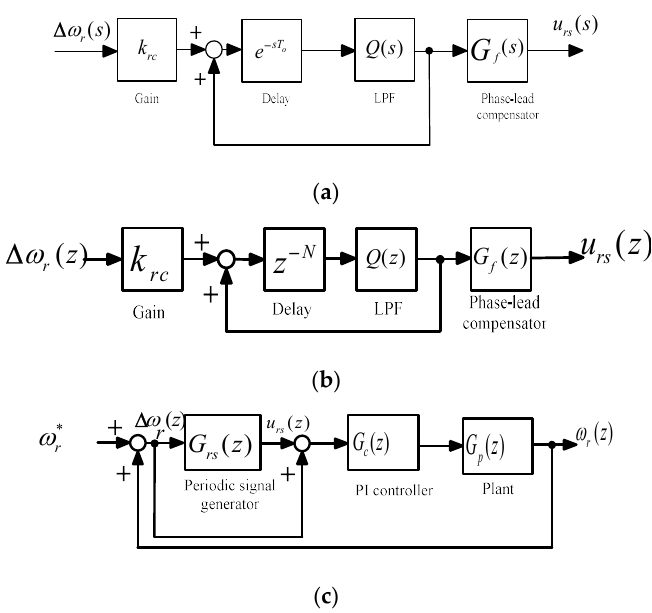
Figure 3. Periodic controller in speed-loop: ( a ) s-domain periodic controller G rs ( s ) ; ( b ) z-domain periodic controller G rs ( z ) ; ( c ) closed-loop control